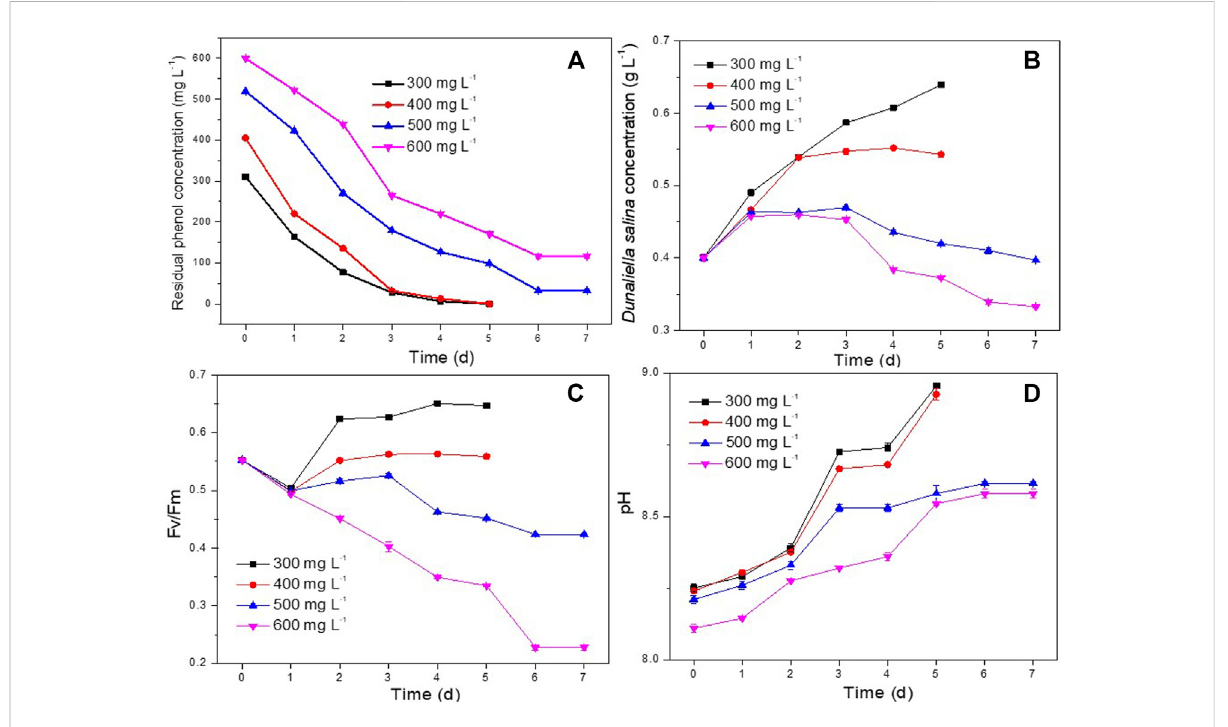
FIGURE 6 Effect of phenol concentrations on phenol degradation and the growth of D. salina : phenol removal ef fi ciency (A) , biomass concentrations (B) andFv/Fmvalues (C) of D.salina andpHofculturemedium (D) under 0.4 g L − 1 D.salina , 0.2 gL − 1 H.mongoliensis ,pH7.5, 120 μ molm − 2 s − 1 and 25 ° C